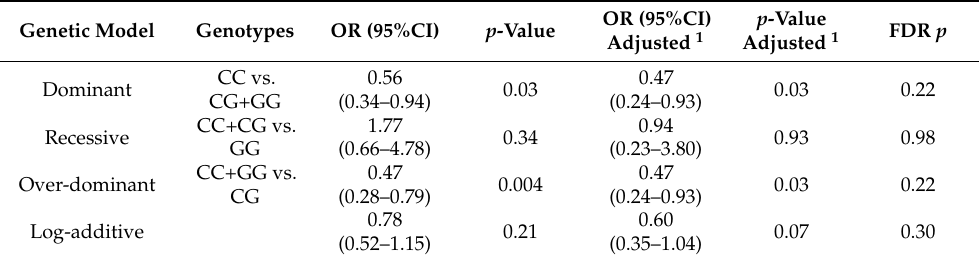
Table 4. Association Between TRPM8 rs2052030 and COPD Under Different Genetic Models.